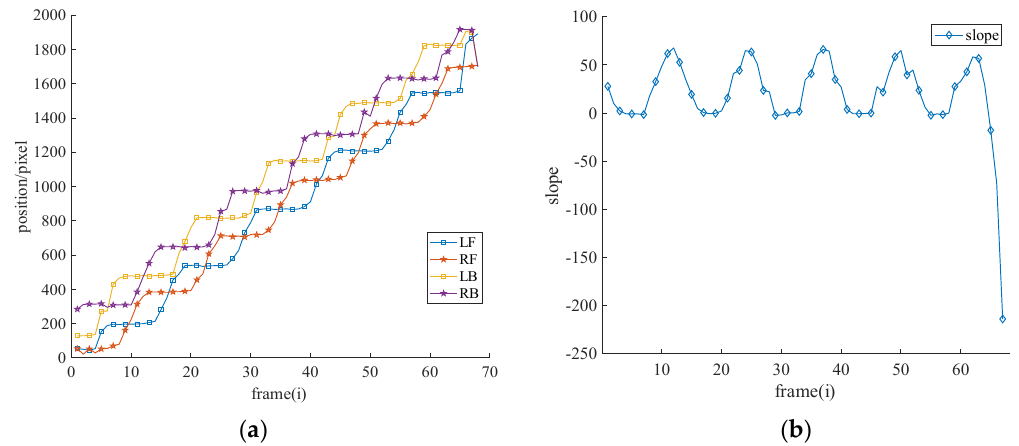
Figure 15. ( a ) Dog’s feet displacement curve; ( b ) first−order differential curve of dog’s feet displacement. The quadruped animal’s left front leg, right front leg, left hind leg, and right hind leg, as well as the first-order differential slope, are represented in the above image by the letters LF, RF, LB, and RB, respectively. Since the camera is fixed during the recording of the video material, it is clear from the figure that when quadrupeds move forward, their limbs alternately swing. Therefore, the experimental animal’s foot displacement direction should be monotonic, moving from right to left when its features are monotonically reducing, and from left to right when they are monotonically growing.